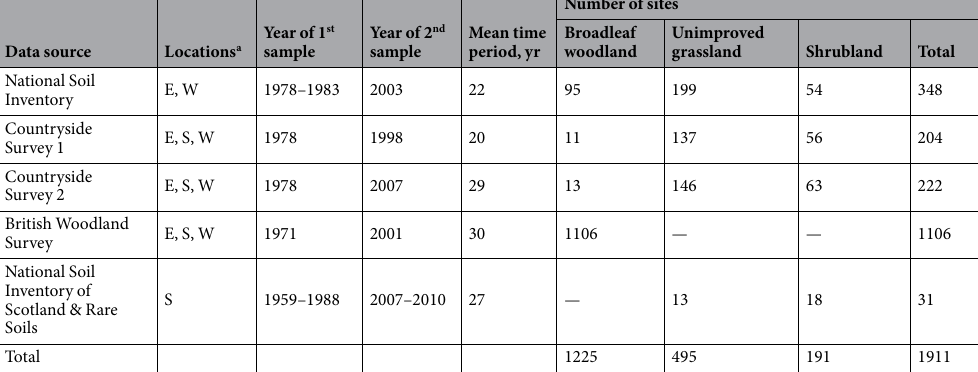
Table 1. Summary of topsoil resampling sites. a E- England, S- Scotland, W- Wales.